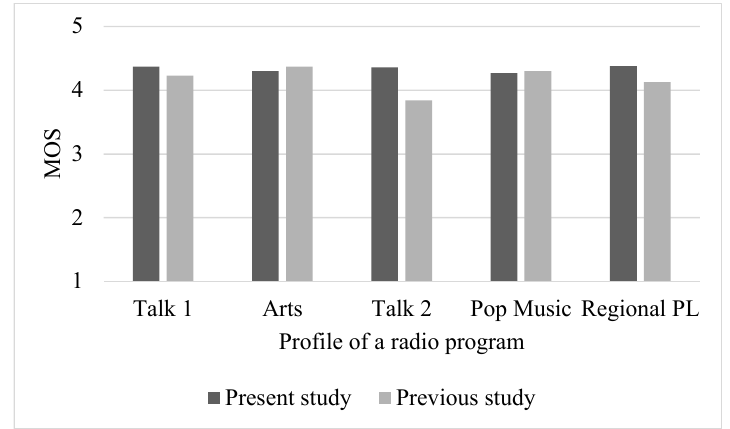
Figure 2. Comparison of subjective quality evaluation.